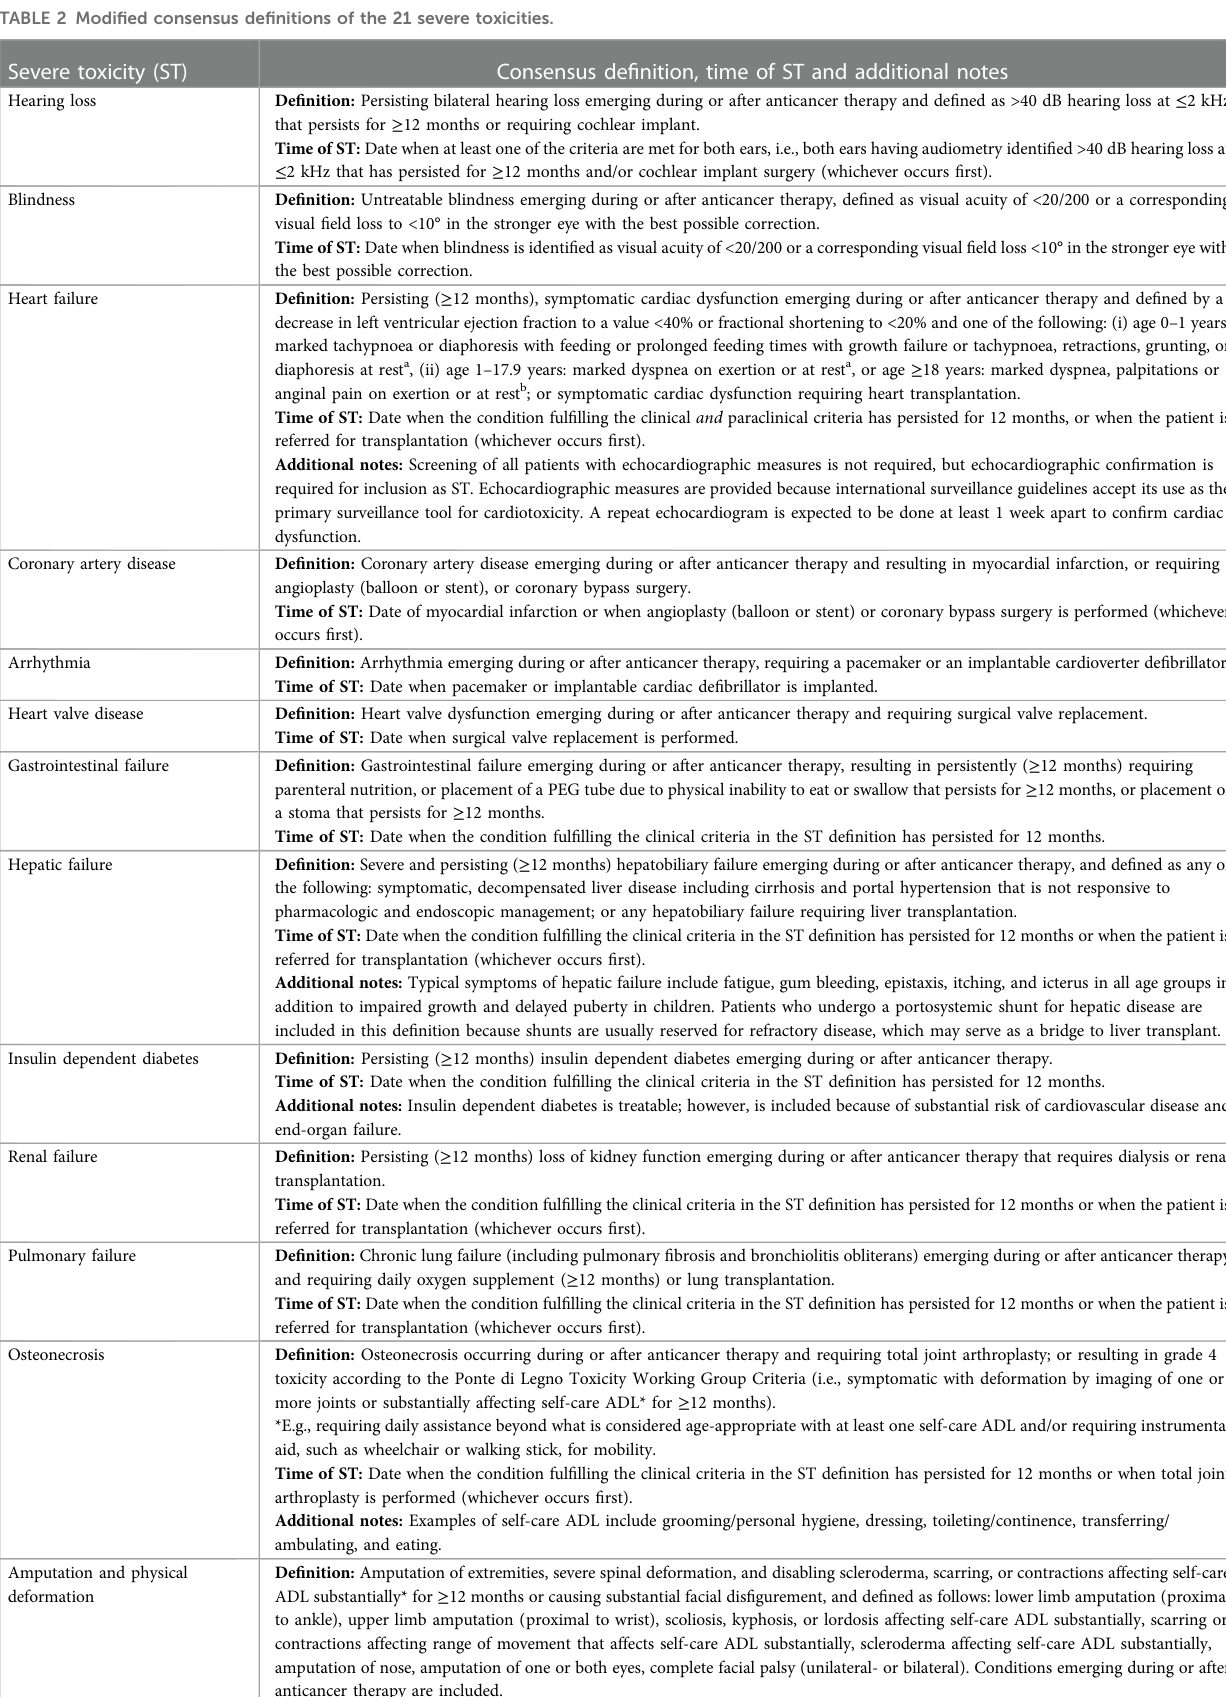
TABLE 2 Modi fi ed consensus de fi nitions of the 21 severe toxicities. Severe toxicity